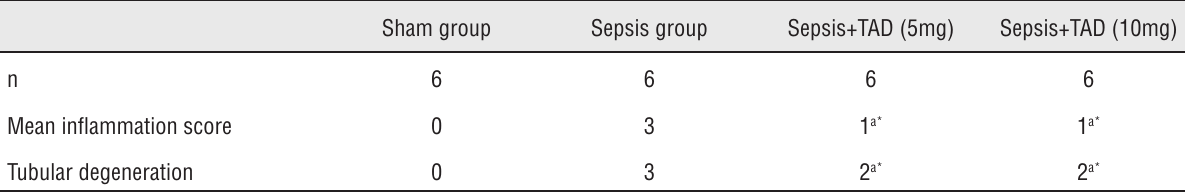
Table 5 - Histopathological variations in renal